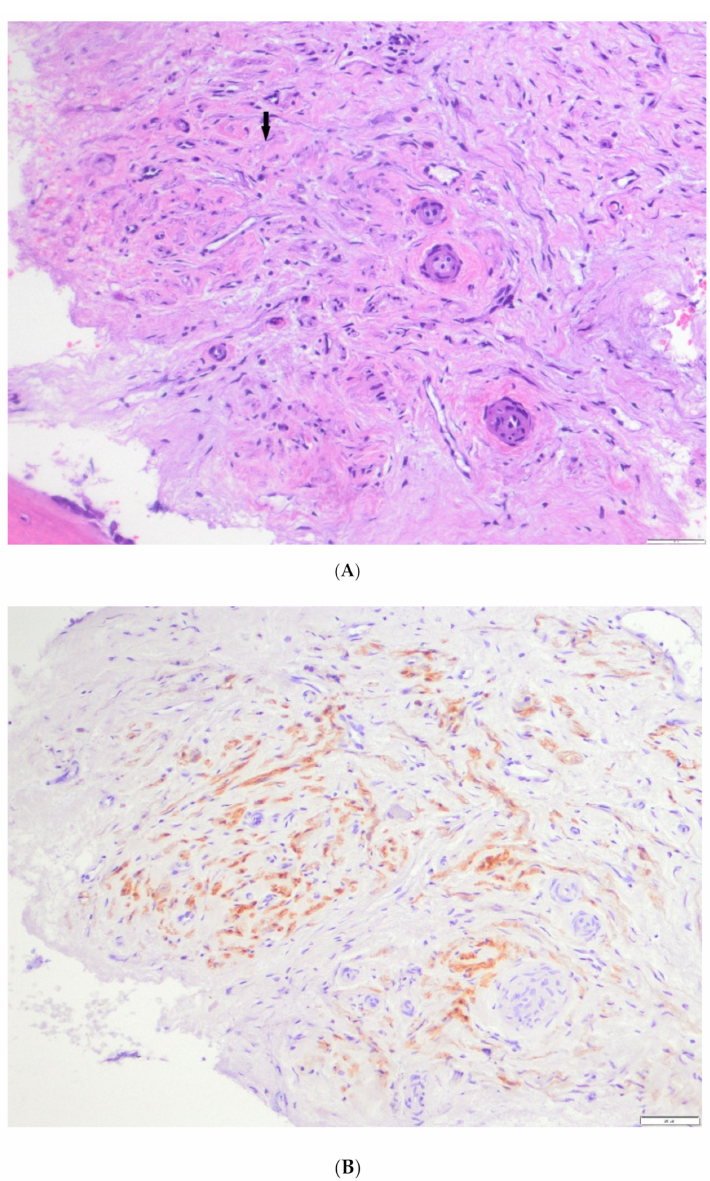
Figure 6. Describes case #5 (Tables 1 and 2) biopsy of the right sphenoid bone. ( A ) Histology consists of only Schwann tissue (arrow) with no evidence of neuroblastic cells. ( B ) Schwannian stroma shown by S100